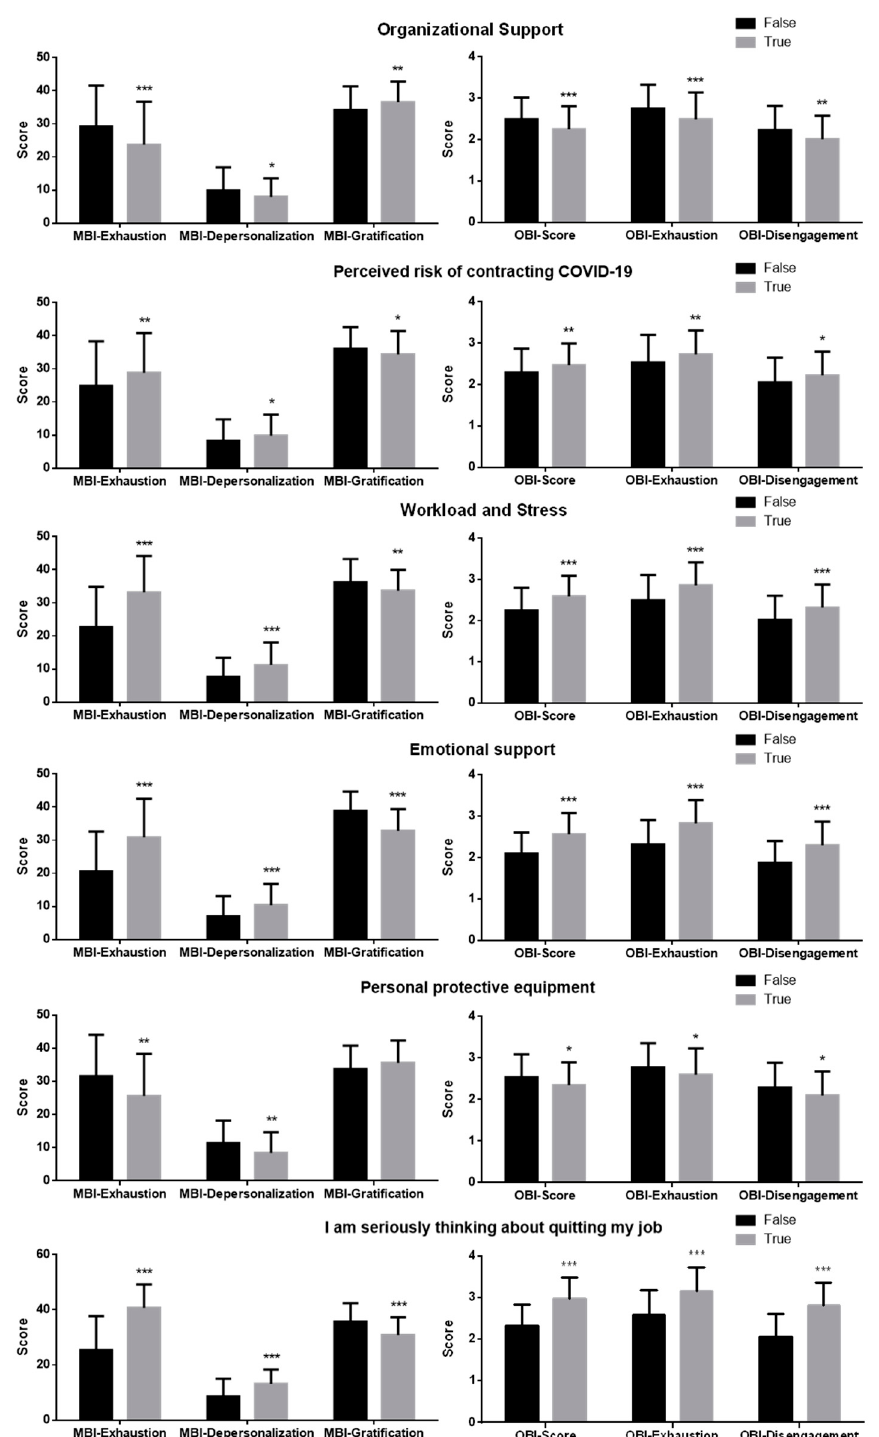
Figure 1. Comparison of scores obtained by the Maslach Burnout Inventory (MBI) and the Oldenburg Burnout Inventory (OBI) in participants grouped according to the working factors reported in the graph titles. Data are expressed as mean ± standard deviation. Statistical differences were assessed by independent student’s t -test. * = p < 0.05; ** = p < 0.01; *** = p < 0.001. Univariate analysis showed that factors associated with burnout (detected by both questionnaires) in nurses were consideration of leaving the job (F = 23.809, p < 0.001), workload and stress (F = 12.567, p < 0.001), and emotional support (F = 33.812, p < 0.001),